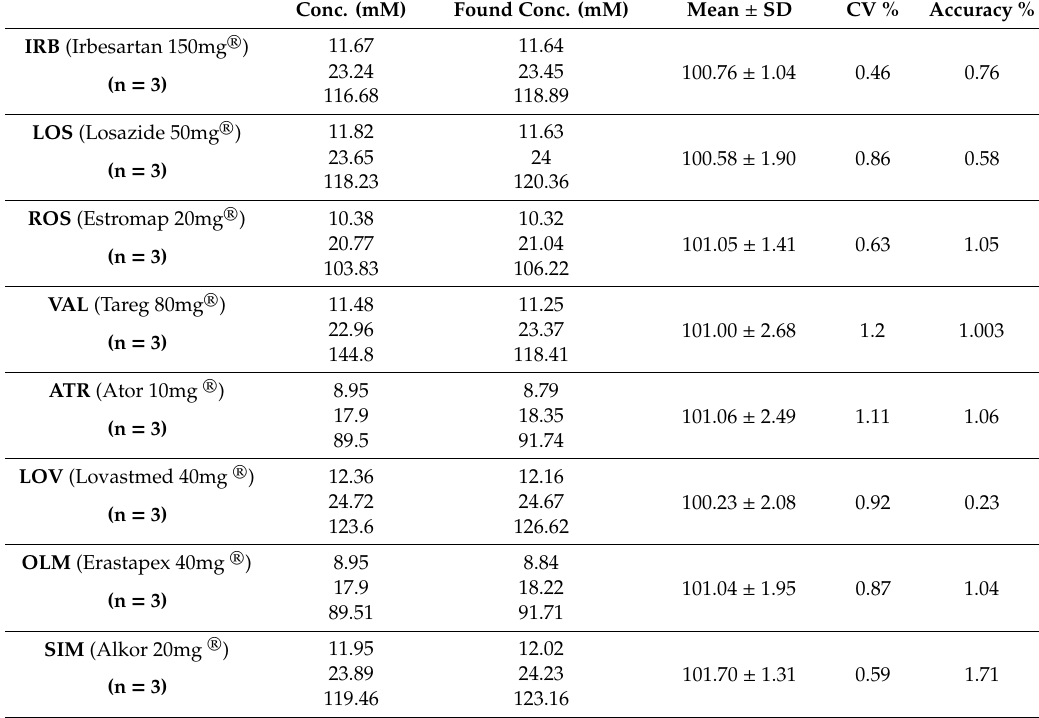
Table 3. Application of standard addition technique for the determination of Irbesartan ® (IRB), Losazide ® (LOS), Estromap ® (ROS), Tareg ® (VAL), Ator ® (ATR), Lovastmed ® (LOV), Erastapex ® (OLM), and Alkor ® (SIM) tablets using the proposed method. Conc. (mM) Found Conc.